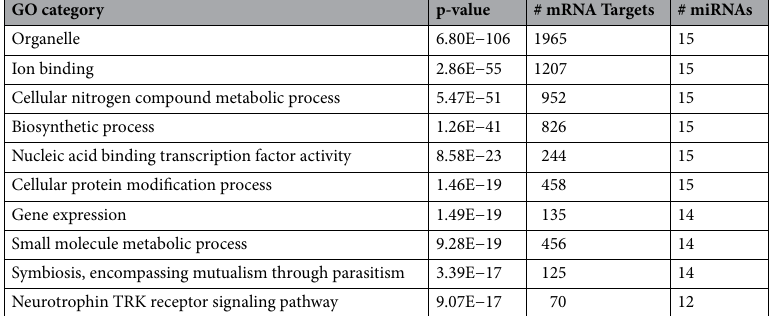
Table 7. Top 10 FDR Significant, GO categories associated with the high expressing 15 human milk extracellular vesicle miRNAs in cluster 1, determined with microT-CDS. GO gene ontology, FDR false discovery